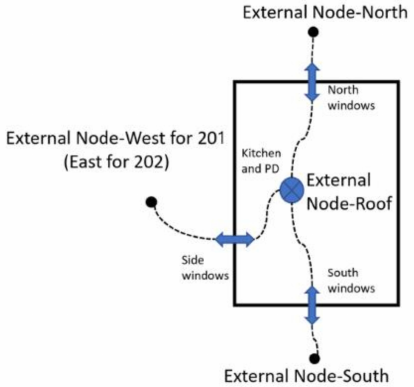
Figure 7. Infiltration route description of the air flow network in